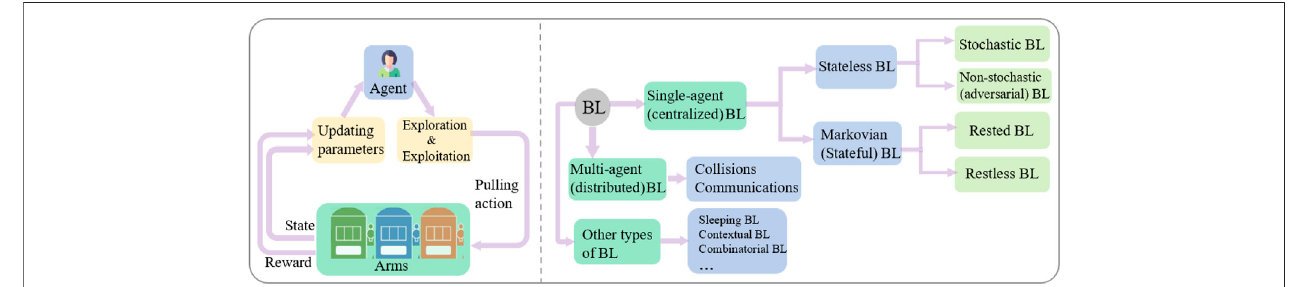
FIGURE 1 | The work fl ow of BL and a representative Classi fi cation of